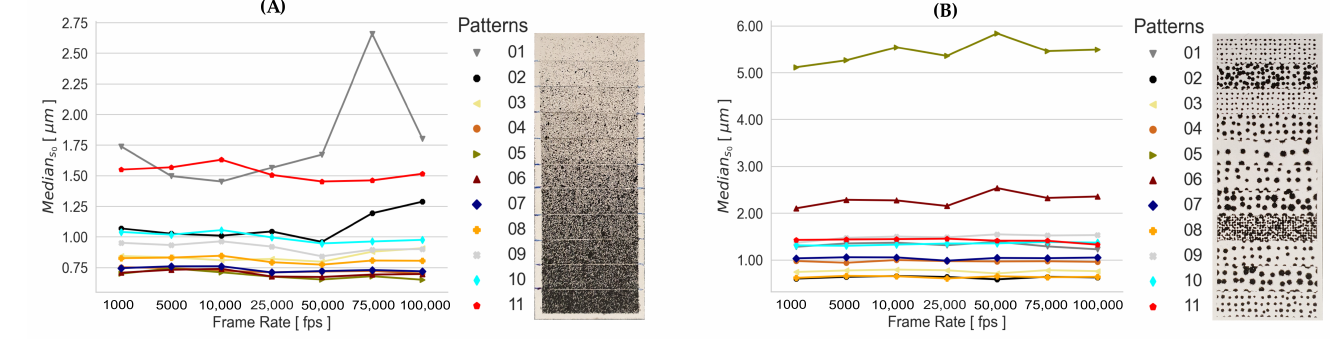
Figure 8. Median s 0 of the transformations obtained from the static experimental configurations using the calibration parameter set of 04 Calibration, as presented in Figure 2, for ( A ) RPs and ( B )